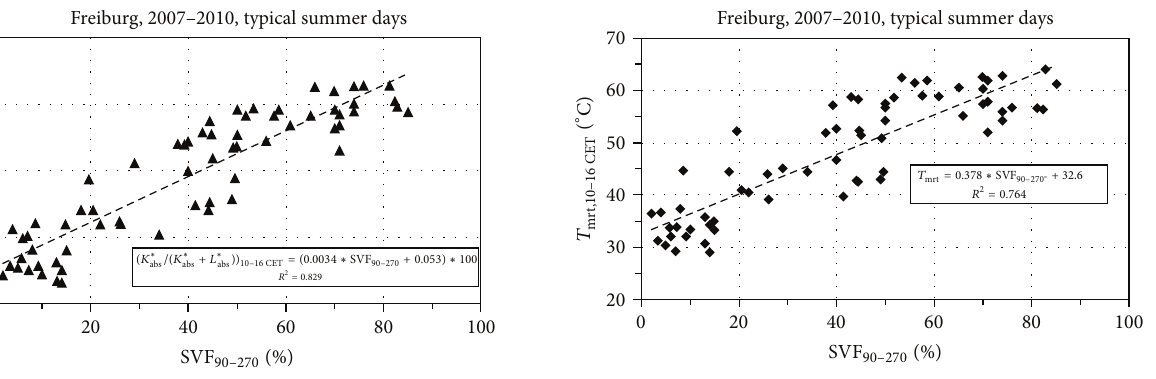
Figure 24: Relationship between mean values (10–16CET) of /(𝐾 ∗ + 𝐿 ∗ ) ) and SVF ( 𝐾 ∗ 90 – 270 , based on human-biometeoro- abs abs abs logical measuring campaigns at different sites in Freiburg on typical summer days 2007–2010.